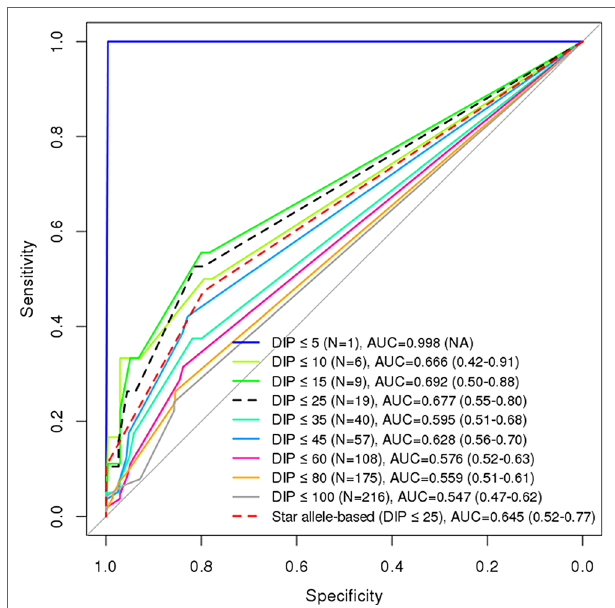
FIGURE 5 | Comparison of diagnostic accuracies between combined ( NUDT15 and TPMT ) star allele-based molecular phenotyping and GVB scoring for 6-mercaptopurine intolerance in ALL. Diagnostic accuracies are measured by using AUC analysis for GVB NUDT15 , TPMT (DeLong’s p -value = 0.175). Numbers in the last parentheses indicate AUC with 95% confidence intervals. DIP, dose intensity percent; AUC, area under the curve.